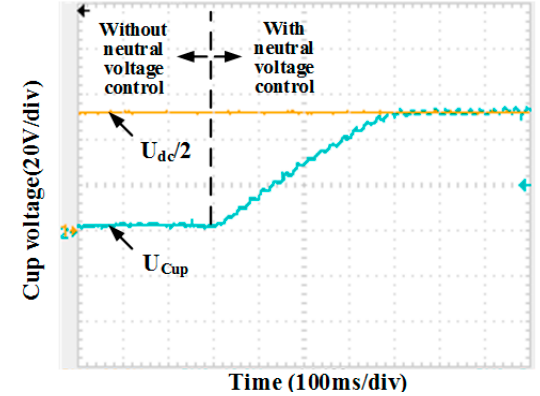
Figure 11. Measured performance of neutral voltage control.